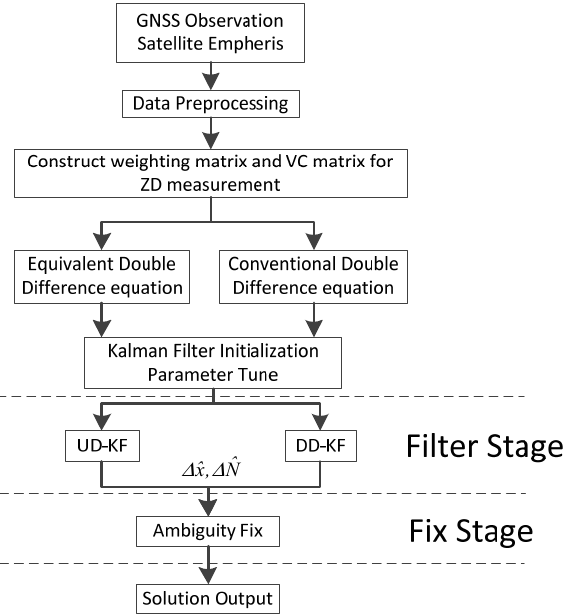
Figure 2. Flow chart of UD-Factorization implementation for KF based on equivalent principle.